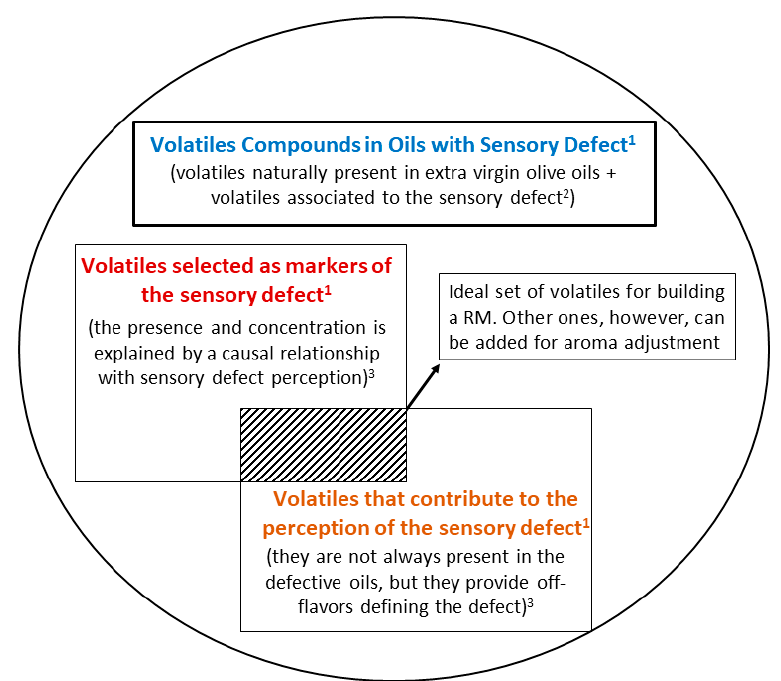
Figure 1. Scheme to select volatile compounds as candidates to formulate RMs of aroma sensory defects detected in VOOs. Note: 1 in this work sensory detect refers to rancid or winey-vinegary; 2 volatiles can result from oxidation (rancid defect) or fermentation (winey-vinegary defect) processes; 3 the concentration of these compounds may exceed or not their odor threshold, and can or cannot smell like the sensory defect.